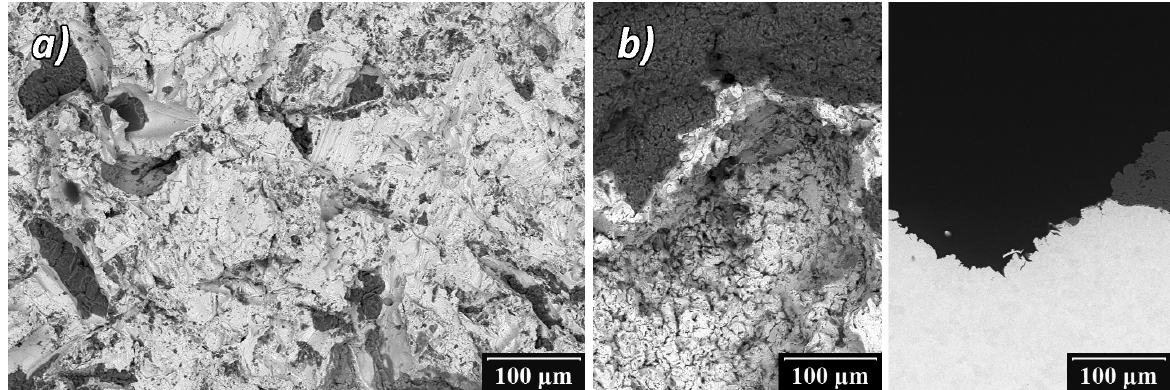
Figure 8. a) Exposure of the original grit-blasted substrate surface at the bottom of the cavitation crater (coating AW24). b) Cavitation pit penetrating substrate (coating SR119). Free-surface (left) and cross-section (right).